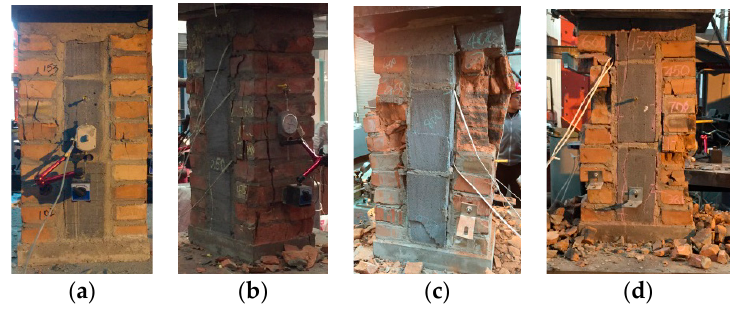
Figure 7. Failure states of AFCB1–AFCB4: ( a ) AFCB1; ( b ) AFCB2; ( c ) AFCB3; and ( d ) AFCB4.